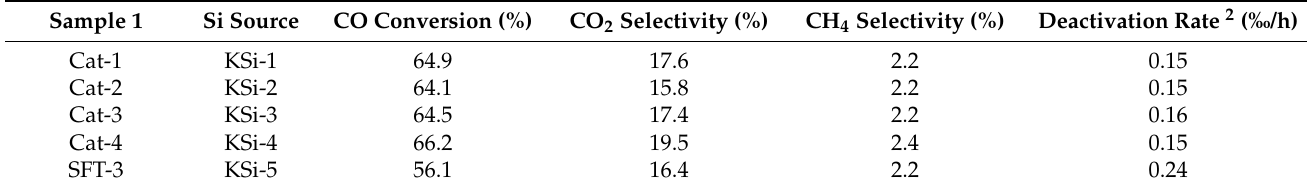
Table 7. Fischer–Tropsch synthesis performances of catalysts with different silica sources 1